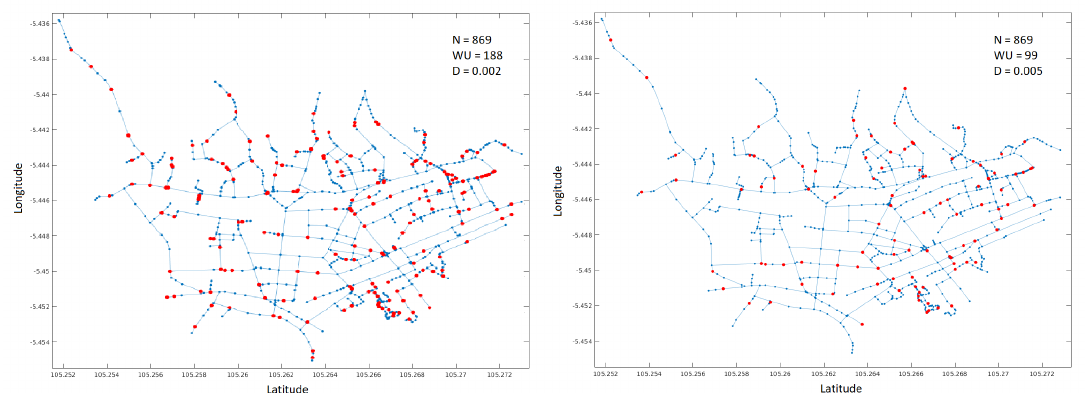
Figure 5. Solutions for the Bandar Lampung case. Left D = 0.002, right D = 0.005.